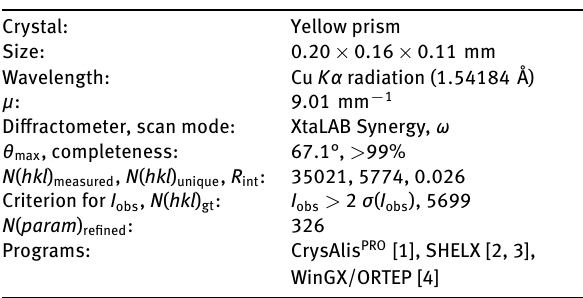
Table 1 contains crystallographic data and Table 2 contains the list of the atoms including atomic coordinates and dis- placement parameters. Table 1: Data collection and